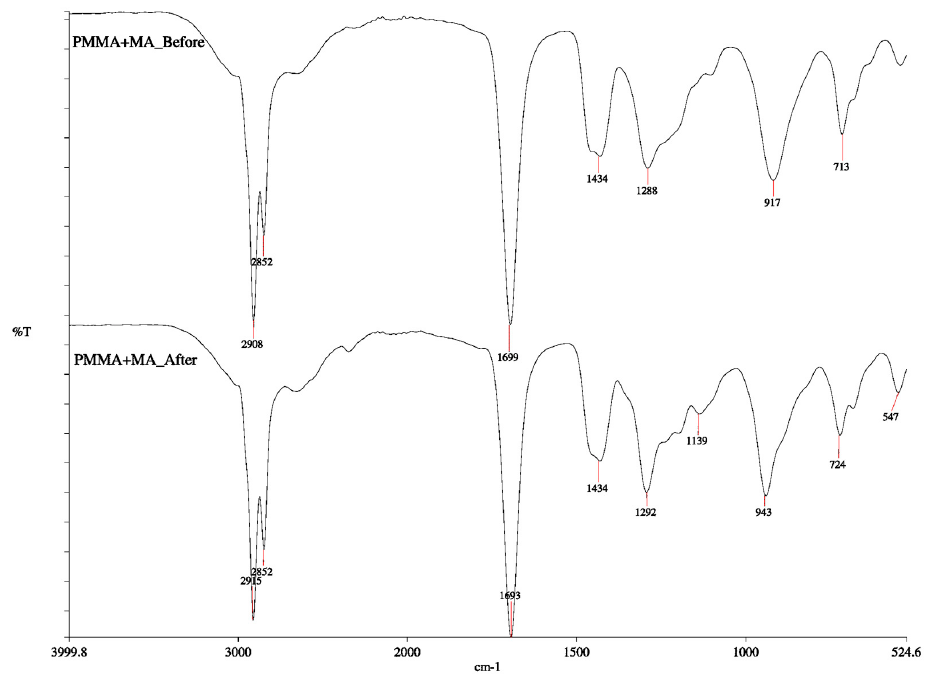
Figure 8. FTIR analysis of the PCM before and after cycling.